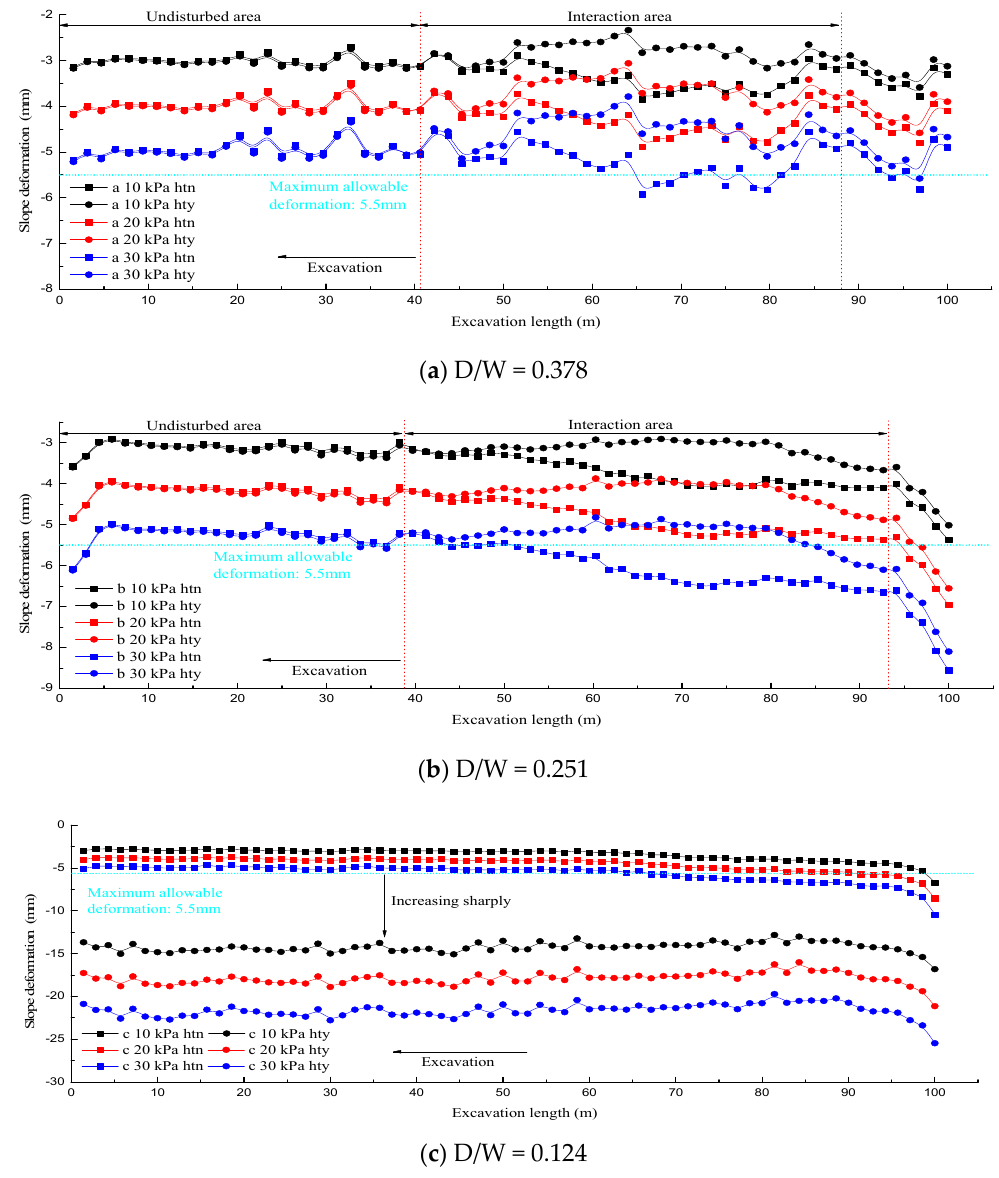
Figure 20. Longitudinal surface settlement of models A-A to C-C with C/H = 0.764.